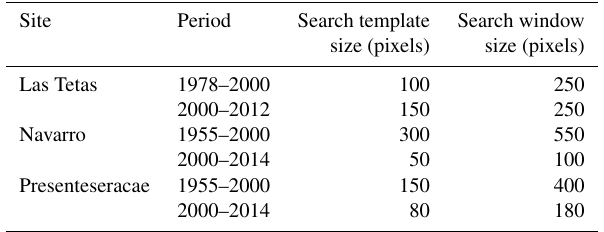
Table 3. Sizes of search template and search window used for the image feature